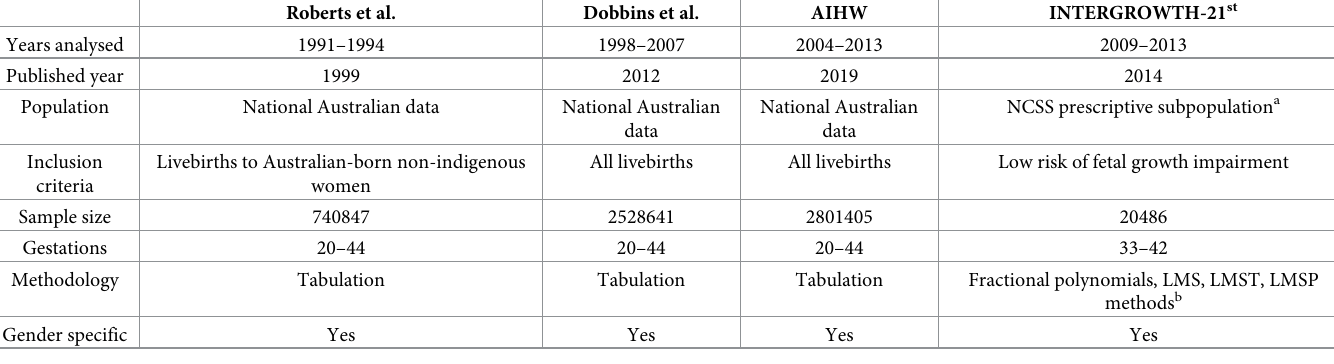
Table 2. Differences between Australian population-based birthweight centile charts and INTERGROWTH-21 st birthweight centile chart. Roberts et al.